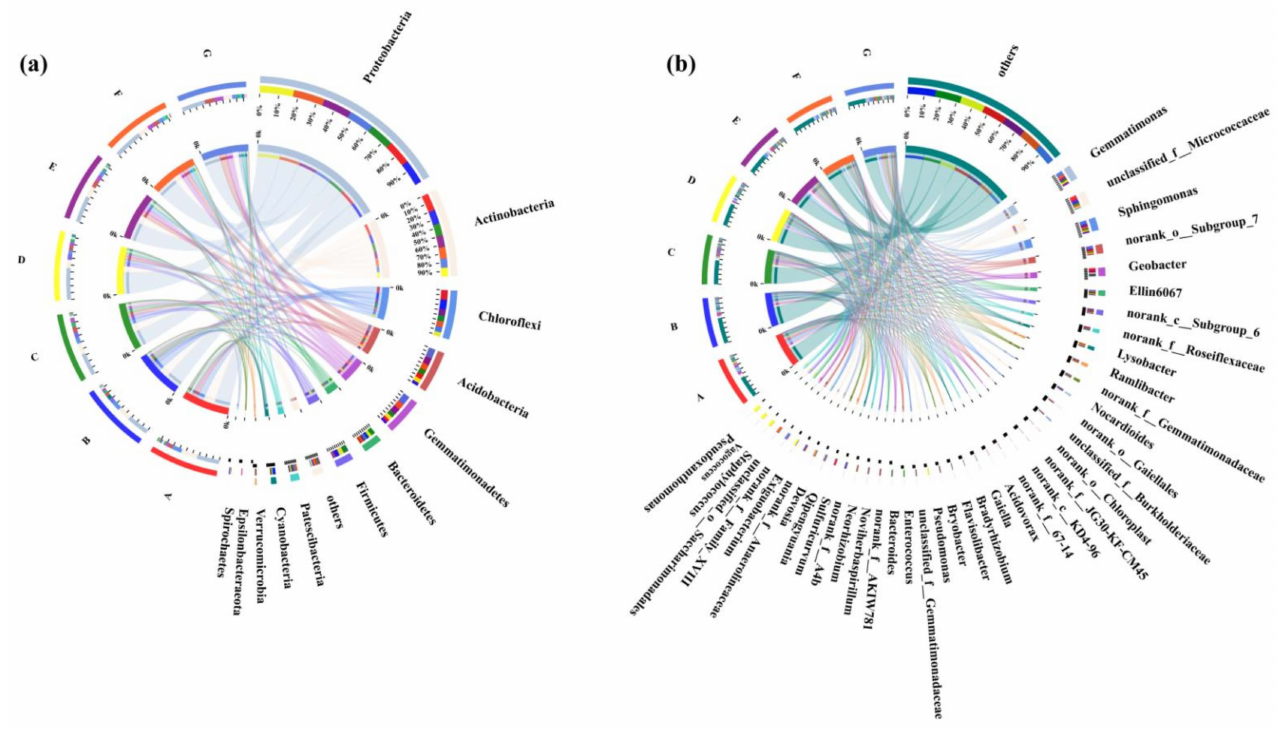
Figure 4. Rhizosphere soil microbial community structure and differences of I. tectorum under Cr stress under different treatments (( a ) Phylum level; ( b ) Genus level). The small semicircle (left half circle) represents the species composition in the sample. The color of the outer band represents the group from which the species are. The color of the inner band represents the species, and the length represents the relative abundance of the species in the corresponding sample. The large semicircle (right half circle) represents the distribution ratio of species in different samples at the taxonomic level. The outer band represents species, the inner band color represents different groups, and the length represents the distribution ratio of the sample in a particular species. A and B are I. tectorum monoculture control and Contamination, respectively; C and D are I. tectorum bio culture control and Contamination, respectively; E and F are the control and Contamination of I. tectorum , respectively. G is for unplanted and bulk soil